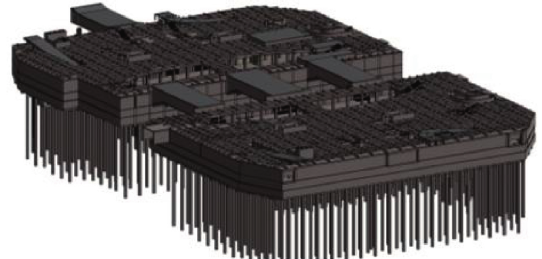
Figure 6: An integrated model of structure and electromechanical